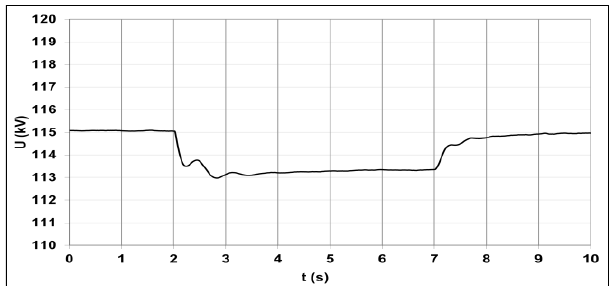
Figure 16. Changes in voltage at the point of the WF connection, resulting from including the farm in voltage regulation.